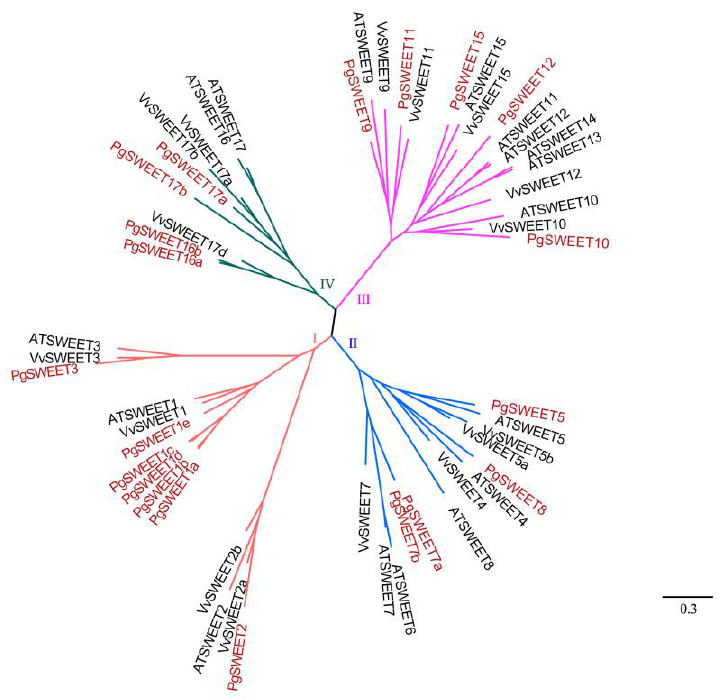
Figure 1. Phylogenetic tree of the SWEET gene family in pomegranate, Arabidopsis and grape.